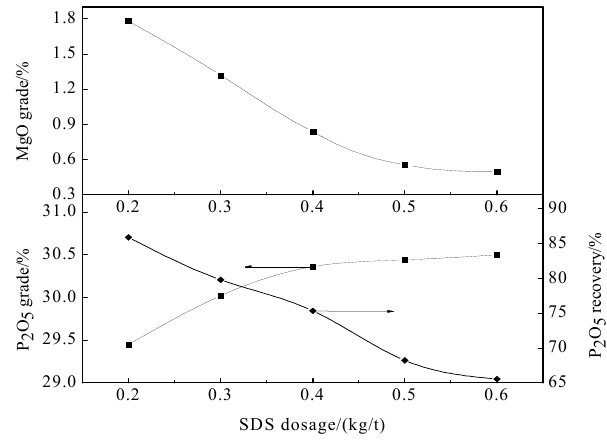
Figure 7. Effect of SDS dosage on concentrate separation indices.